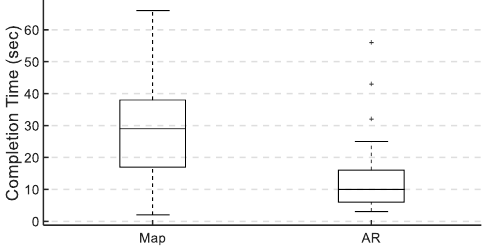
Figure 5. Completion times of the first task